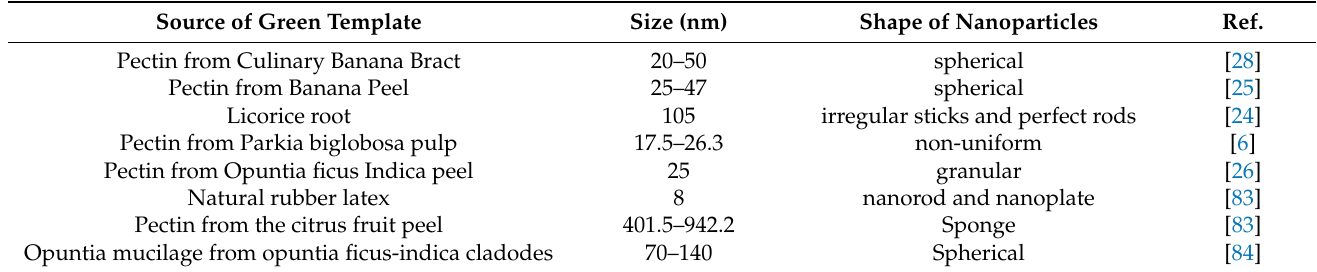
Table 3. Green Template on NHA